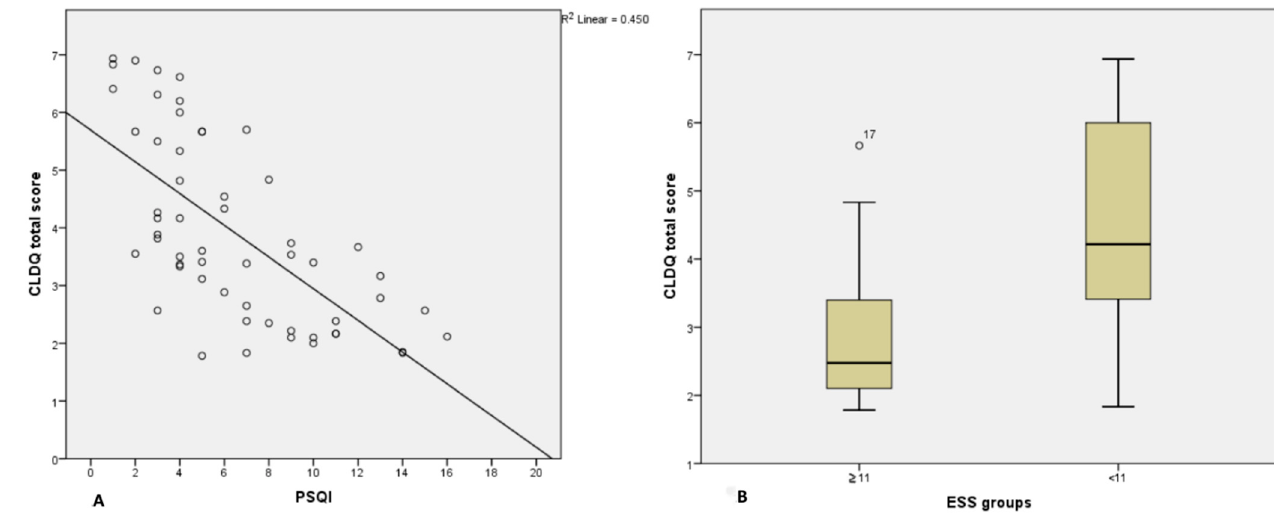
Figure 1. Scatter Plot representing the relationship between PSQI scores and CLDQ scores ( A ) and Box Plot representing the relationship between ESS scores and CLDQ scores ( B ); Abbreviations: PSQI = Pittsburgh Sleep Quality Index, CLDQ = chronic liver disease questionnaire, ESS = Epworth Sleepiness Scale.